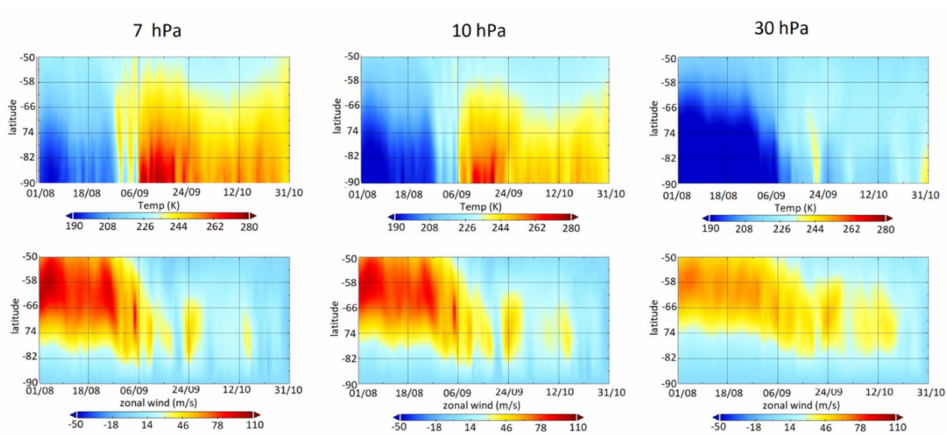
Figure 6. The same as Figure 5 but for the period 1 August 2019–30 October